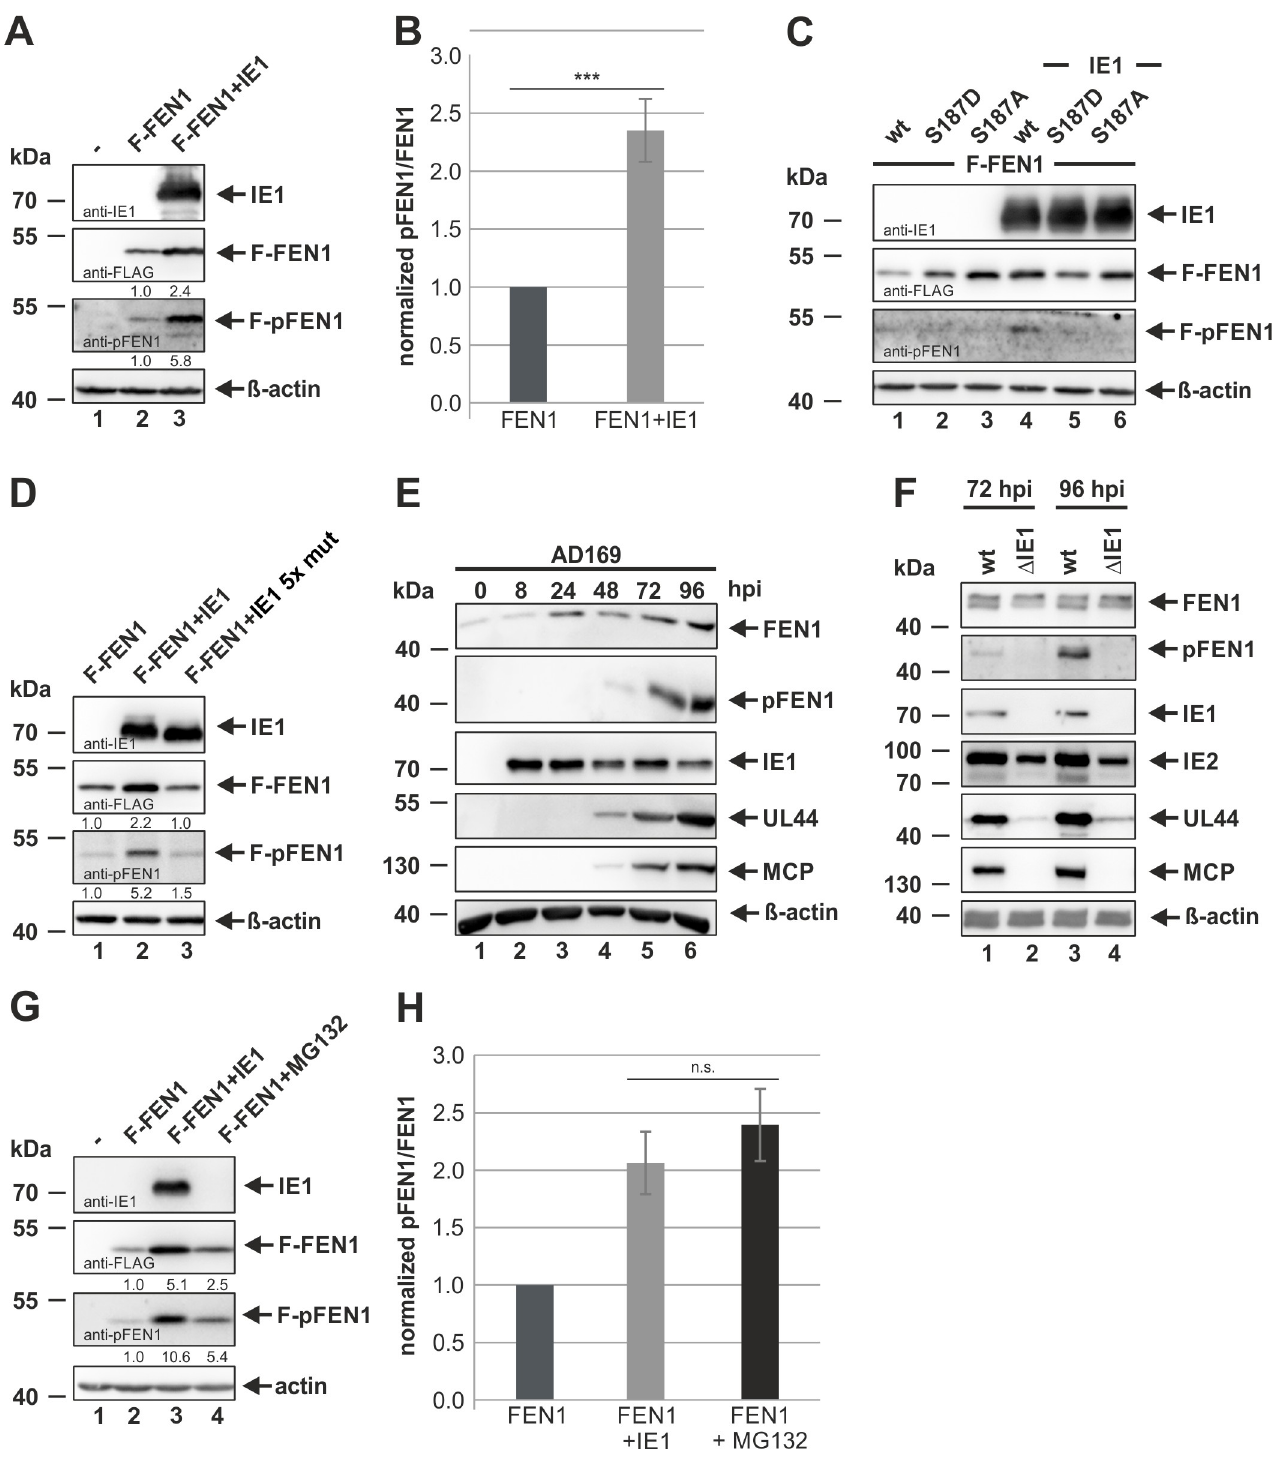
Fig 8. Accumulation of phosphorylated FEN1 species upon IE1 expression. (A, B, C, D, G and H) 293T cells were transfected with the indicated constructs and, at 42 h post transfection, treated with MG132 (5 μ M) when indicated. 48 h post transfection, cells were harvested and analyzed by Western blotting for IE1, FLAG, pFEN1 (Ser187), and β -actin. (A, B, D, G and H) Protein levels of FEN1 and pFEN1 were quantified via densitometric analyses utilizing the Image Lab Software. Protein levels without IE1/MG132 were set to 1. (B and H) Ratios between pFEN1 and FEN1 obtained by three independent experiments are represented by mean values ± SD. The p-values were calculated using two-tailed Student’s t-test. n.s., not significant; ��� , p � 0.001. (E and F) HFF cells were